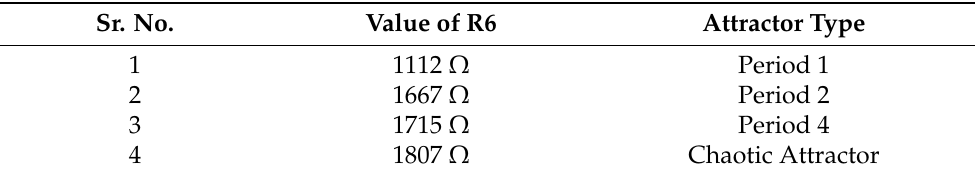
Table 2. Summary of Different Attractor with the variation of Control Resistance R6.